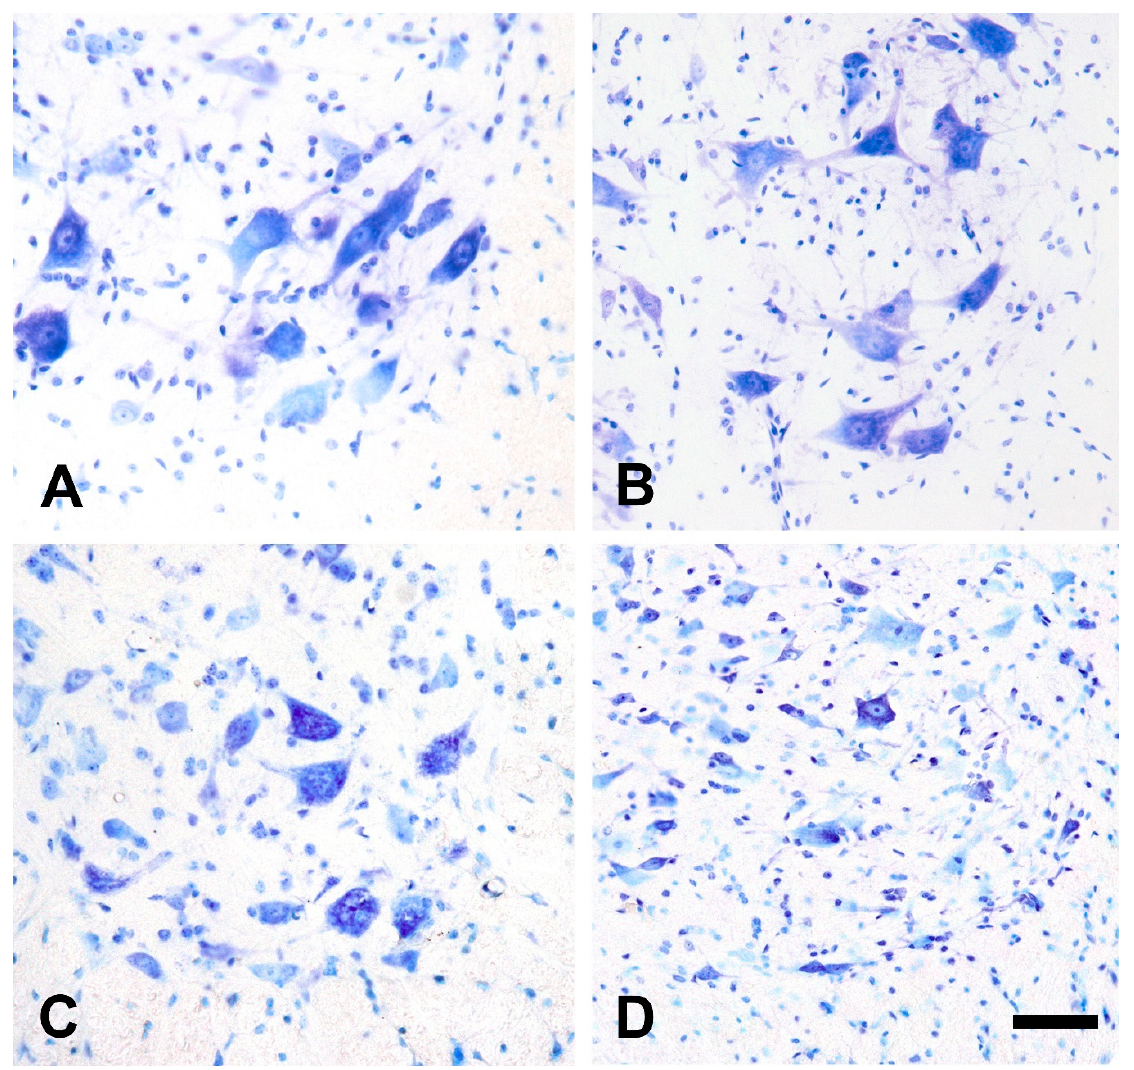
Figure 2. Large cells (>30 µm of characteristic profile size) identified as motor neurons (MNs) are detectable in high number in untreated mice ( A ) or after injection with sera from healthy individuals ( B ). A slight reduction in the number of MNs could be observed after treatment with serum from a patient with superoxide dismutase 1 pLeu144Phe mutation ( C ). The most prominent neuronal loss was noted in the group treated with sera from patients with chromosome 9 open reading frame 72 hexanucleotide repeat expansions, ( D ) where almost all MNs diminished. For representative images from other groups, see Figure S1. Scale bar: 100 µm.